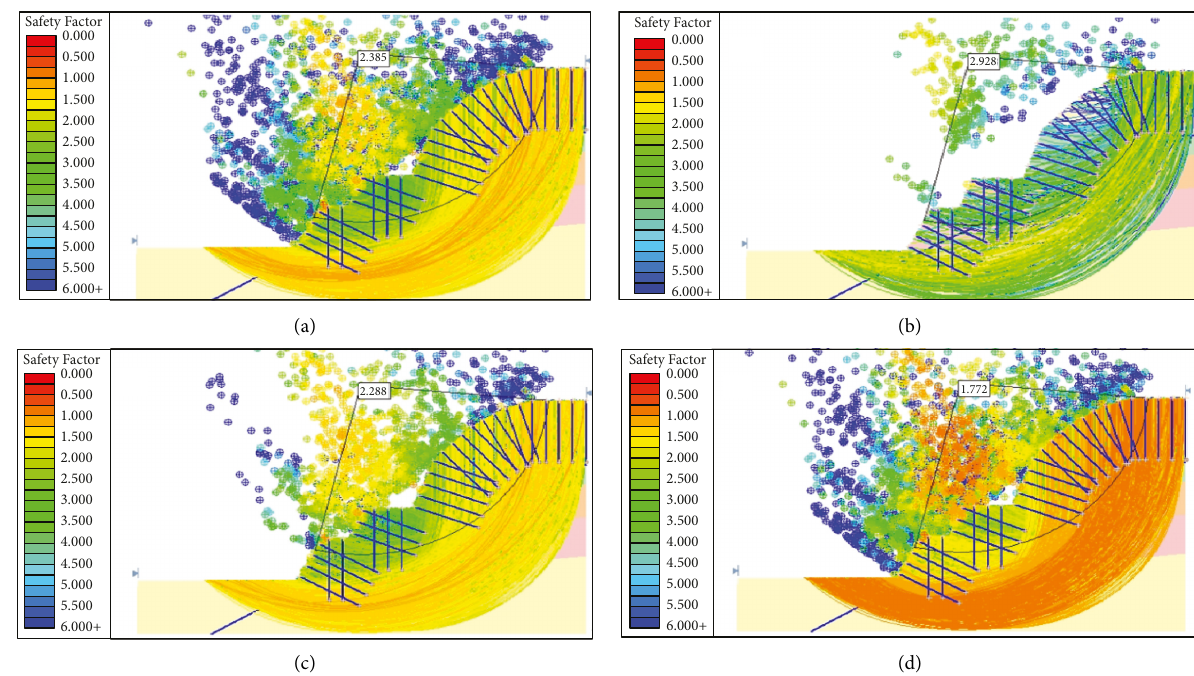
Figure 6: Safety factor simulated for the selected slope with support system installed using (a) Bishop’s simplified method, (b) Janbu’s simplified method, (c) Spencer’s method, and (d) the Corps of Engineers’ Number One method. Strength Factortension 0.52 1.30 2.09